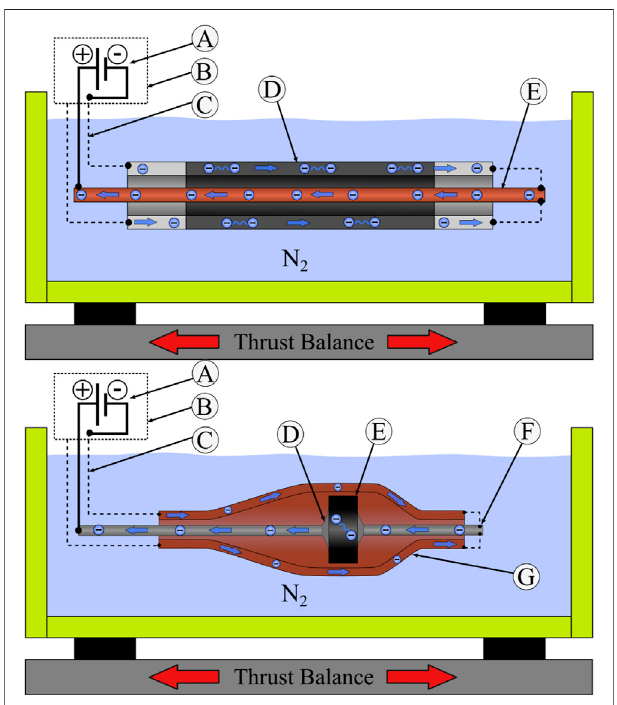
FIGURE 1 | Experimental setup inside a liquid/solid nitrogen reservoir with a coaxial electrical design to investigate thrust generation from cooper- pairs inside a High-T c Superconductor. Top: (A) Current source; (B) Mumetal shield; (C) Coaxial cable; (D) BSCCO current lead; (E) Copper rod. Bottom: (A) Current source; (B) Mumetal shield; (C) Coaxial cable; (D) Indium solder joint; (E) YBCO bulk; (F) Inner wire AWG18; (G) Copper tube.